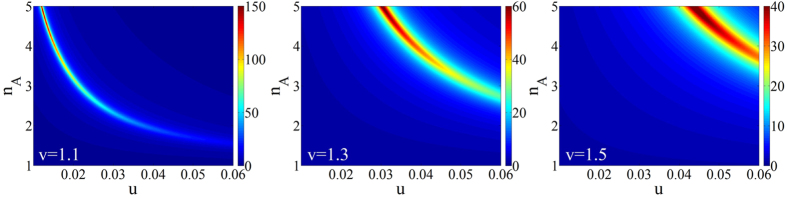
DoA (the degree of asymmetry) dependence on u and nA, when v = 1.1, 1.3, and 1.5.